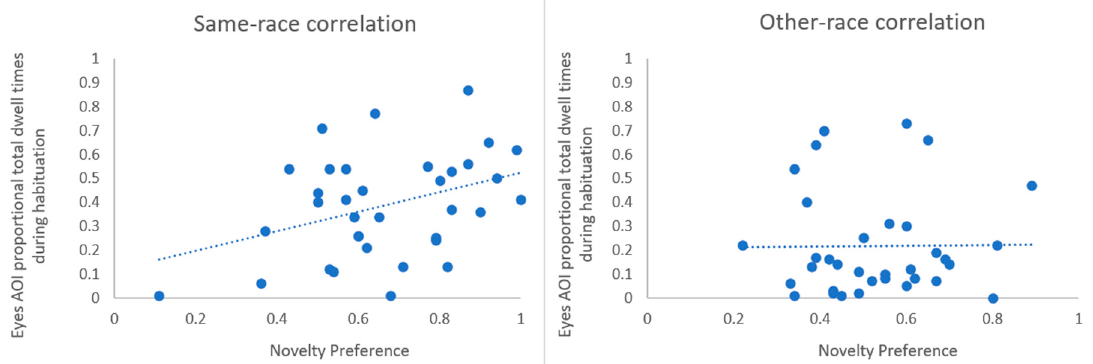
Figure 5. Correlation between infants’ novelty preference scores during testing and their proportional total dwell times for the eyes AOI during habituation in the same-race condition ( left ) and the other-race condition ( right ).